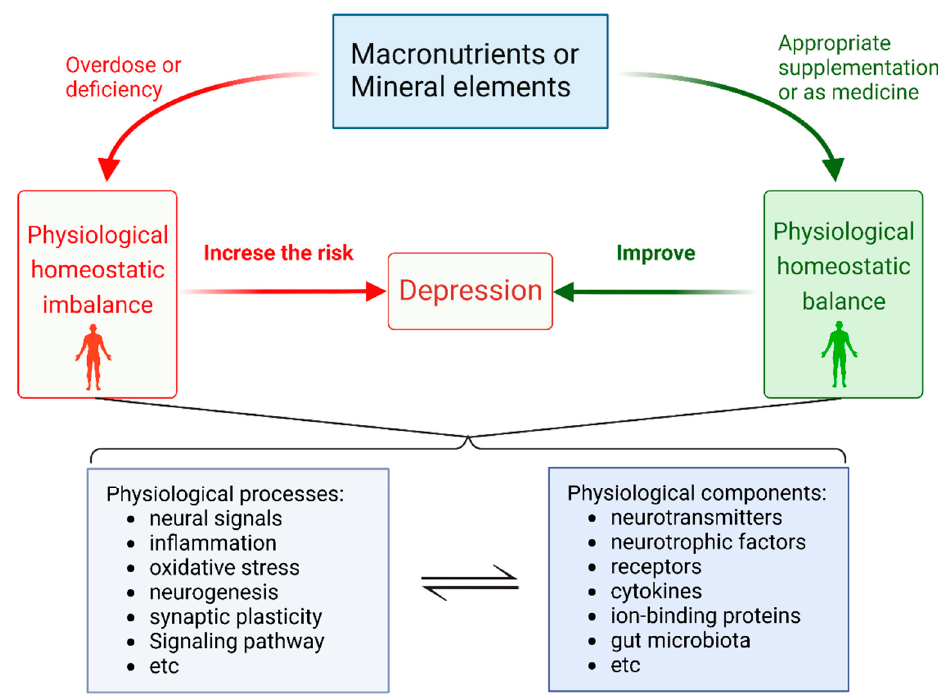
Figure 1. Illustrating the relationship between depression and macronutrients or mineral elements and possible mechanisms including physiological processes and components.